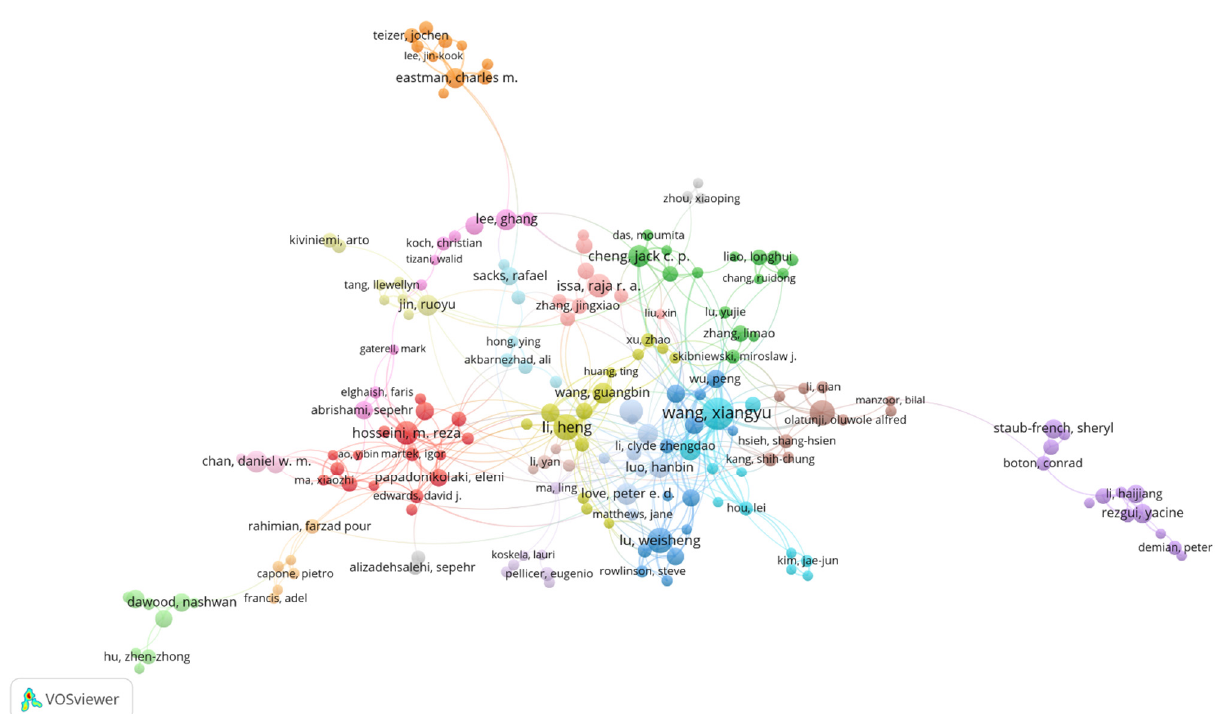
Figure 9. Network of document co-citations analysis.